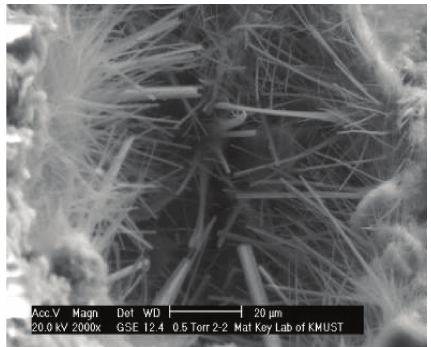
Figure 12: SEM picture of calcium